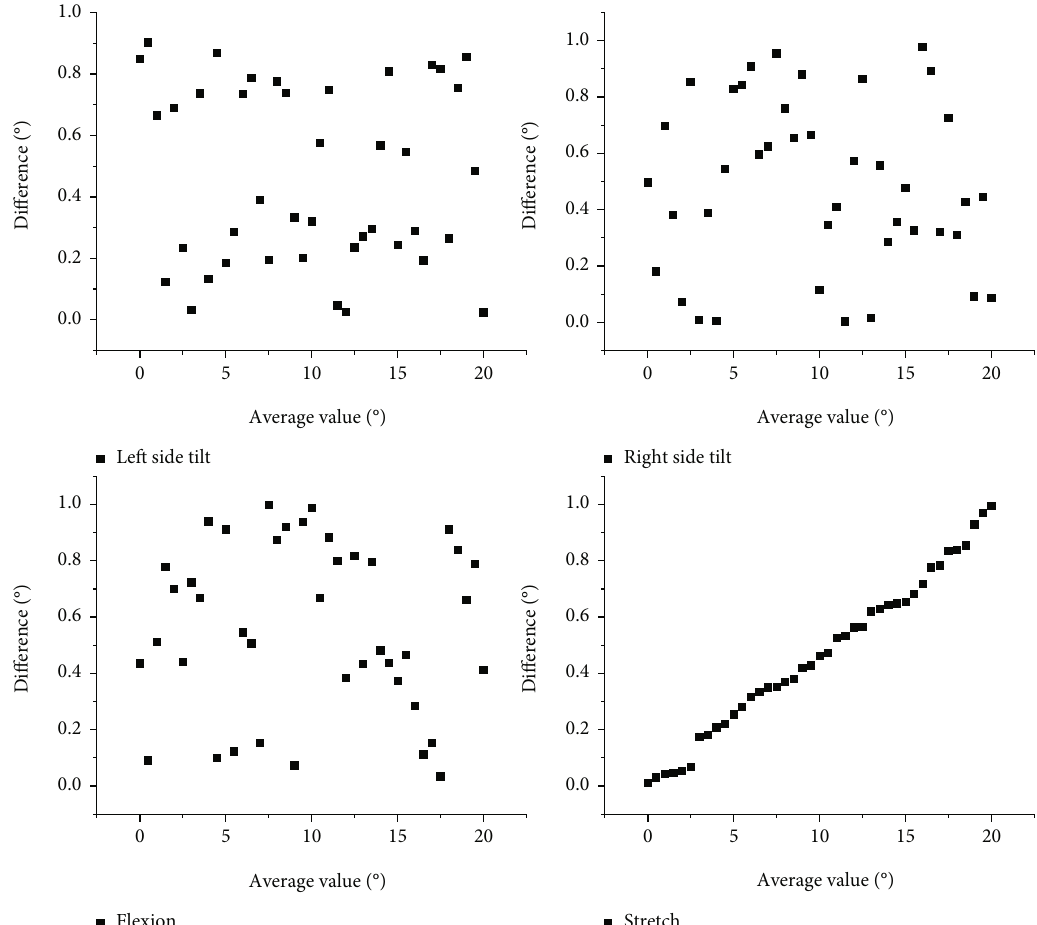
Figure 7: Bland-Altman diagram of cervical mobility measured by orthopedic